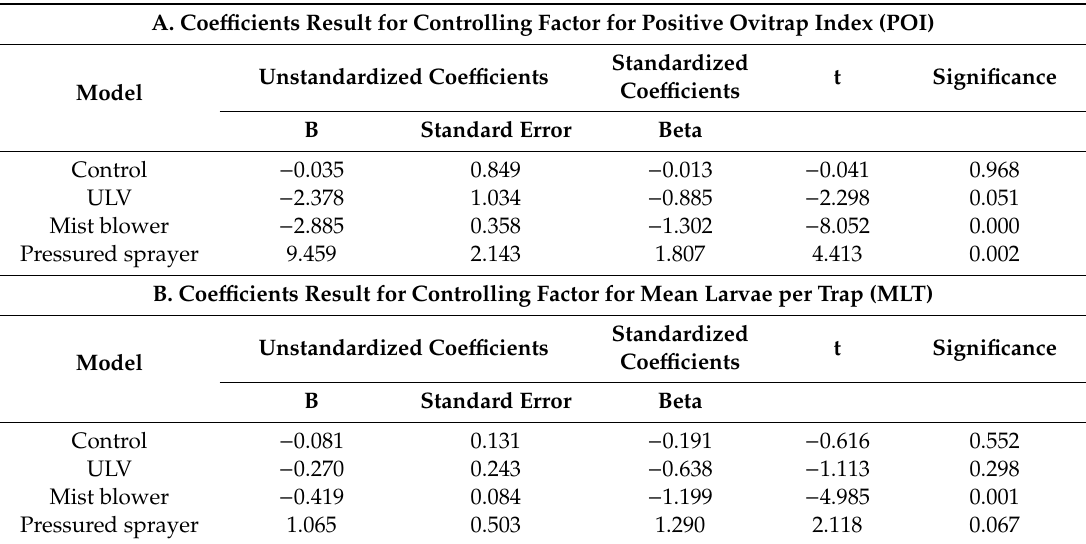
Table 4. Coe ffi cients result for controlling factor for ( A ) positive ovitrap index (POI) and ( B ) mean larvae per trap (MLT) using hierarchical multiple